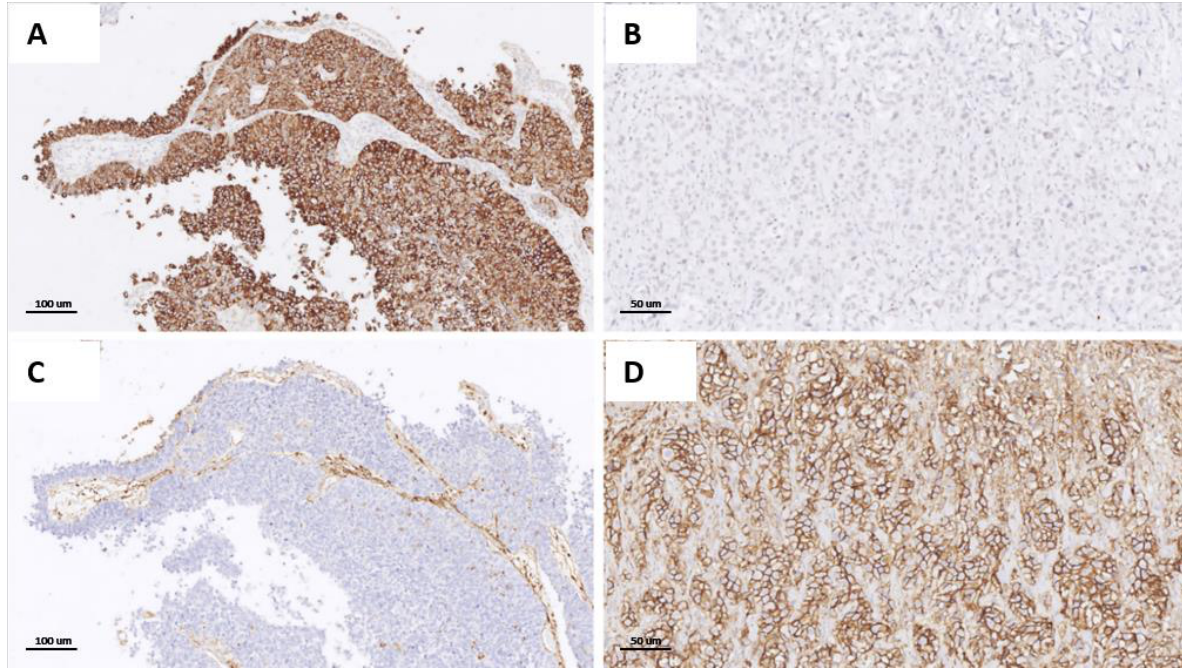
Figure 4. Immunophenotypical change from luminal to basal type in the superficial NMI component (A,C, 200x), and in the MI compartment (B,D, 400x) of the same tumor. ( A ) Superficial component with immunoreactivity for CK20 ; ( B ) MI component in same case with CK20 -negative stain; ( C ) superficial NMI compartment with CD44 -negative stain; ( D ) MI compartment with CD44 -positive stain.